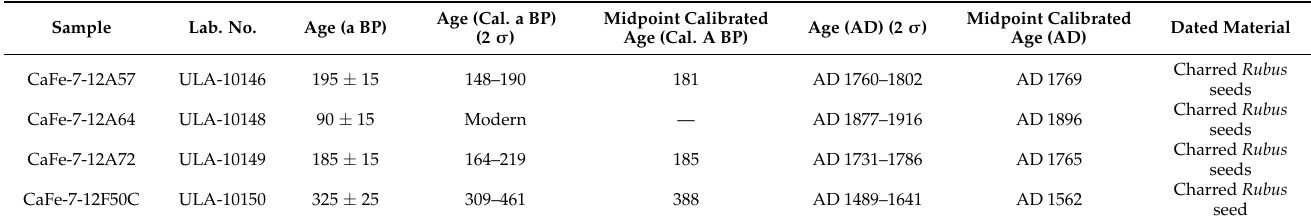
Table 5. Radiocarbon and calibrated ages of the pit features from the Fort Odanak site (CaFe-7).